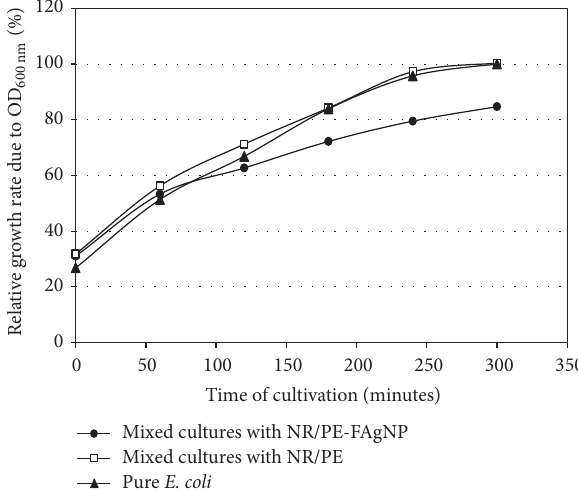
Figure 12: Influence of the NR/PE-FAgNP nanocomposites on the growth rate of the E. coli liquid cultures. The data points represent the means of three cultures (standard deviation <